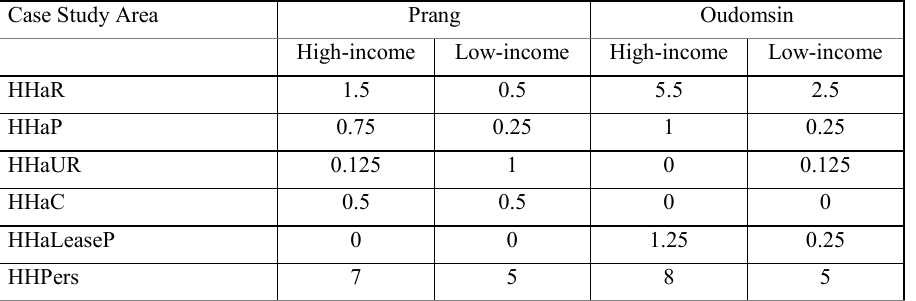
Table A1.3-B: Values of household variables instantiated in the BN to represent low-income and high-income households in each case study area. The values correspond to the variable state in the BN that best matches the values in Table A3-A.